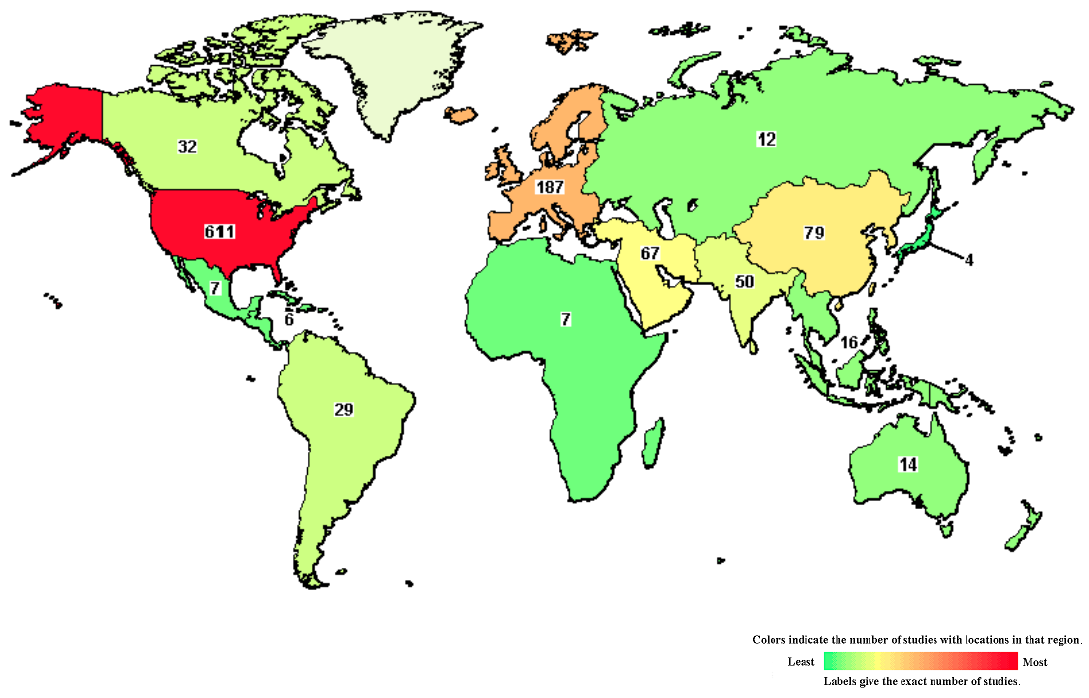
Figure 1. Map of clinical trials on bone marrow stem cells in the world [27]. North America comprises the highest number of trials, followed by Europe, the Middle East, and East Asia.